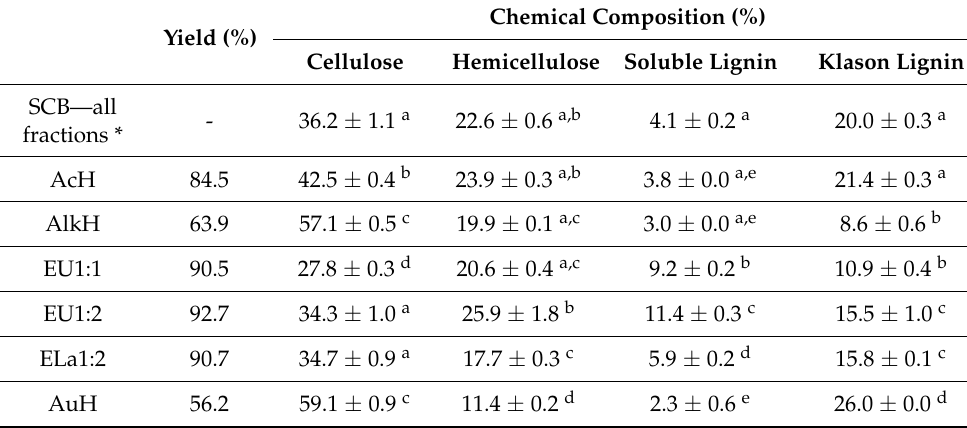
Table 2. Yield and chemical composition (in terms of percentage of cellulose, hemicellulose, and soluble and Klason lignin) of the total fraction of SCB and solid fractions rich in cellulose obtained from different methods. Chemical Composition (%) Yield (%) Cellulose Hemicellulose Soluble Lignin Klason Lignin SCB—all fractions